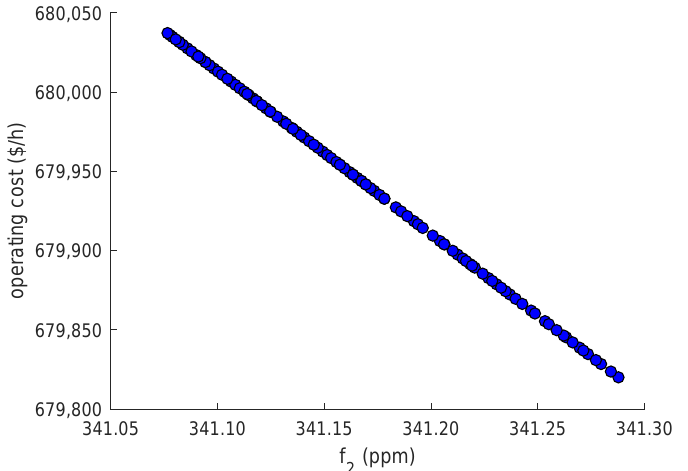
Figure 5. Pareto-optimal frontier for the two-objective optimization problem. Corresponding to Figure 4, the optimal values of the decision variables after 100 it- erations are shown in Figure 6. The subplots in each row of the figure correspond to the relationship between the same decision variable and different objectives, and the sub- plots in each column represent the relationships between the same objective and different decision variables. Analyzing the above three figures from the perspective of decision variables, it can be seen that the top reflux flow rate of T 3 and the bottom reboiler steam flow rate of T 7 are close to the lower boundary. For the objective of total operating cost f 3 , the weight of the T 3 and T 7 reflux flow rates are the largest and the magnitude of these two variables is also large. Thus, the smaller reflux flow rates of T 3 and T 7 imply lower cost. NSGA-III tends to form a small T 3 reflux flow rate and to reduce the T 7 reflux flow